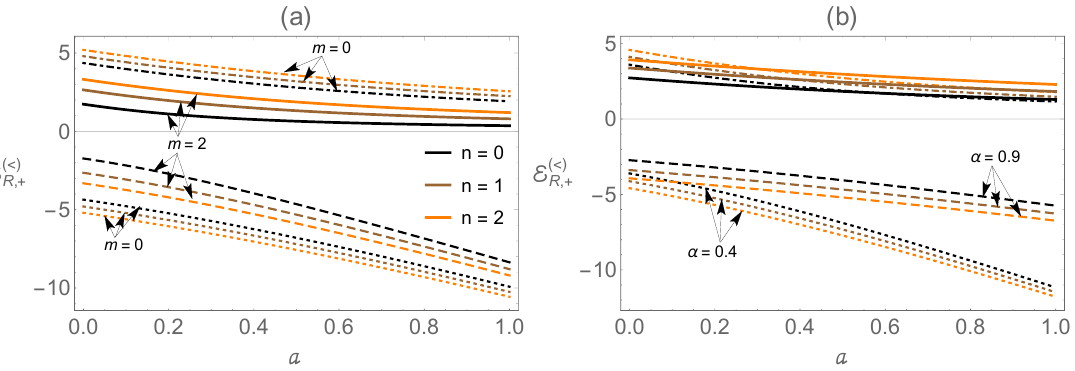
( < ) (Equation (71)) as a function of a . In ( a ), we use α = 0.5, R , +